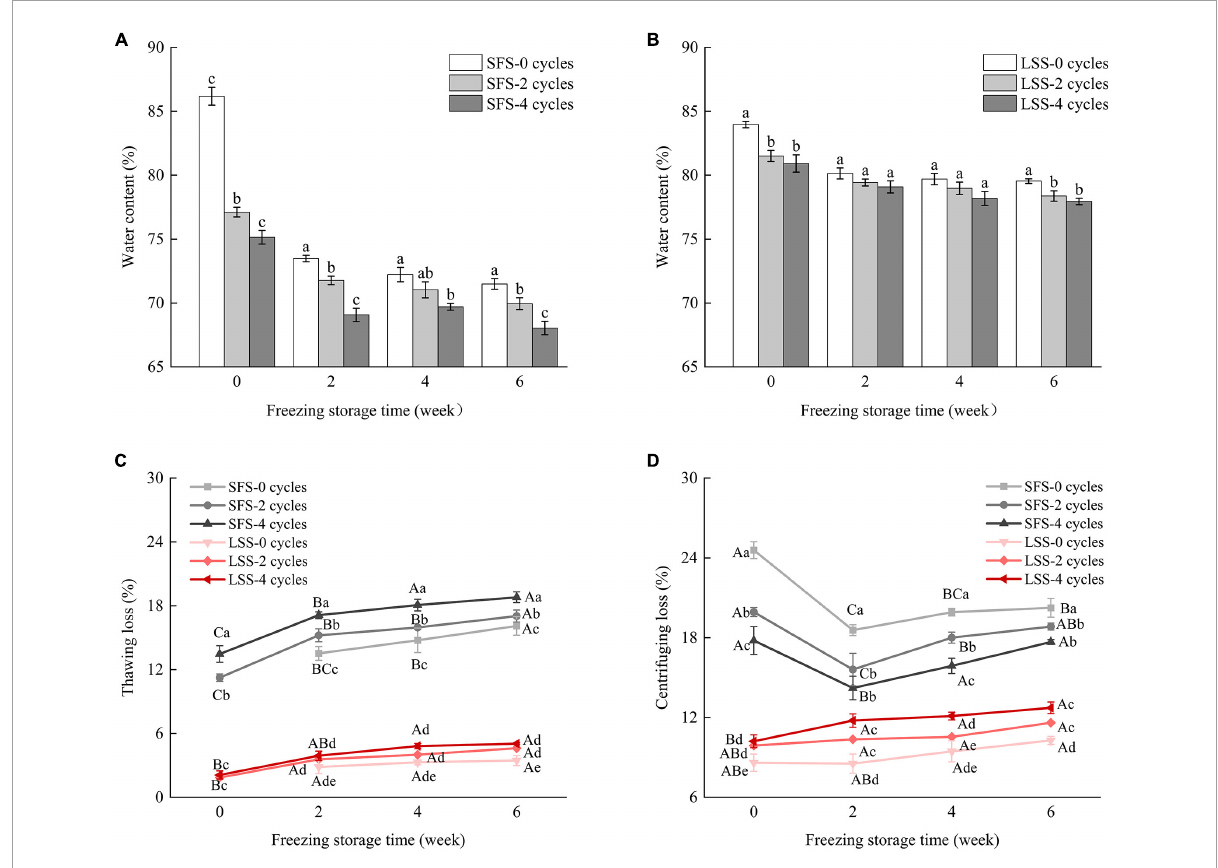
FIGURE5 Changes in moisture content of LYC during frozen storage. (A) Water content of SFS group; (B) water content of LSS group; (C) thawing loss; (D) centrifuging loss. SFS and LSS represent the salt-free soaking group and low-salt soaking group, respectively. Lowercase letters represent significant differences between six samples during freezing, and capital letters present significant differences between samples of different treatment groups during freezing ( P <